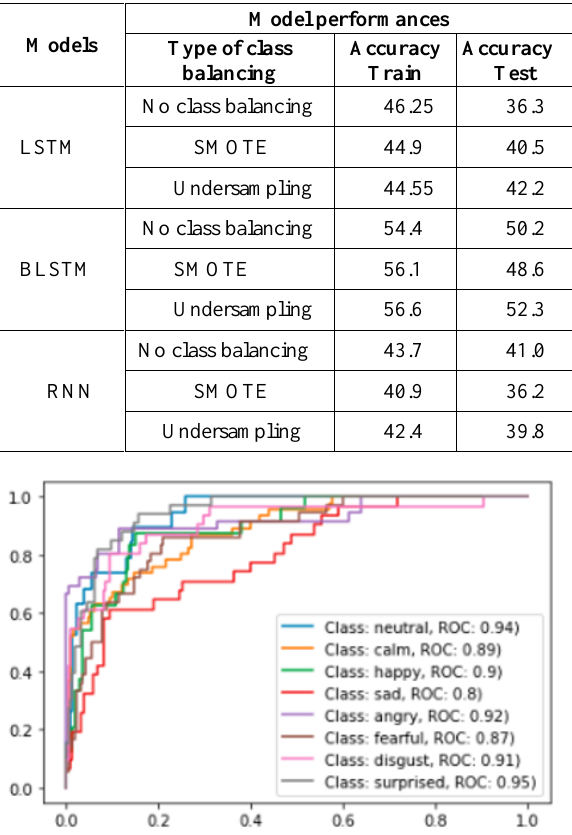
Fig. 2. ROC-AUC curves for emotion classes and their